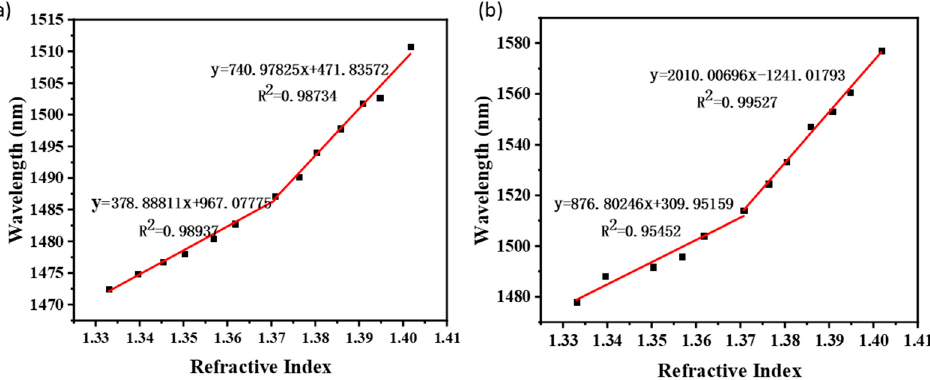
Figure 7. Linear fitting results of two traditional tapered sensors: ( a ) sensor with the waist diameter µ m and ( b ) sensor with the waist diameter of 20 µ of a 40 μ m and ( b ) sensor with the waist diameter of 20 μ m. of a 40